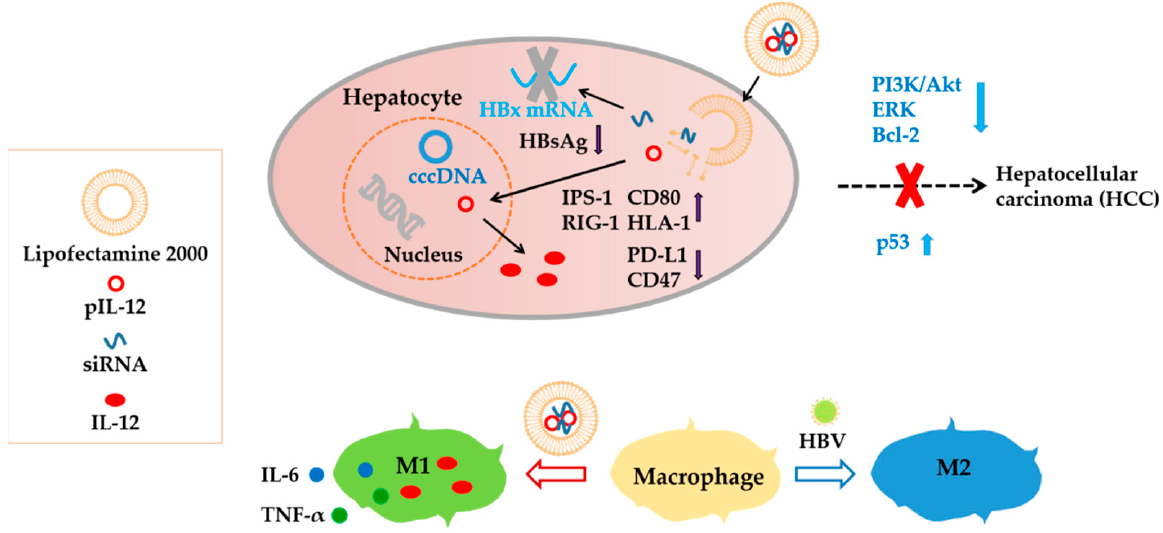
Scheme 1. Overview of anti-hepatitis B and immunomodulatory effects of codelivery of siRNA and